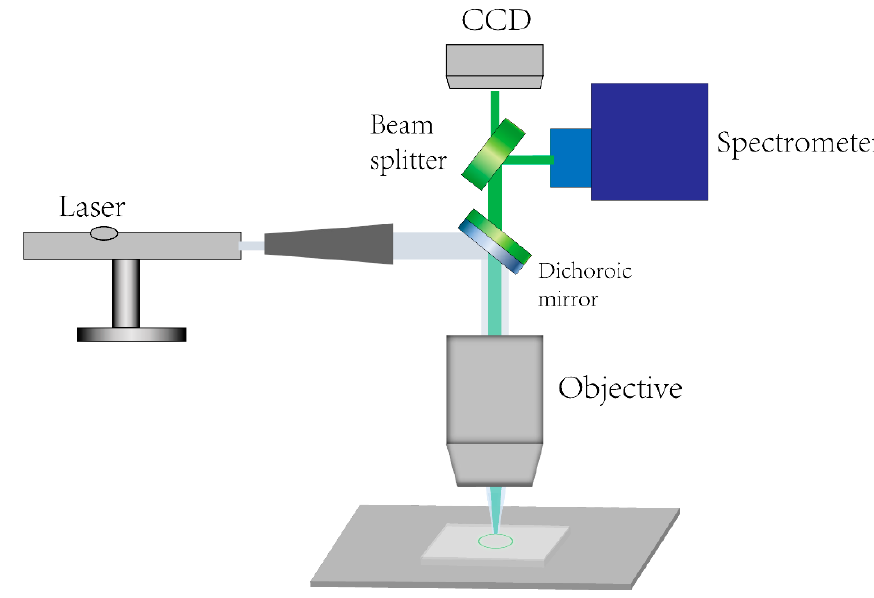
Figure 4. Schematic diagram of the excitation and analysis system.